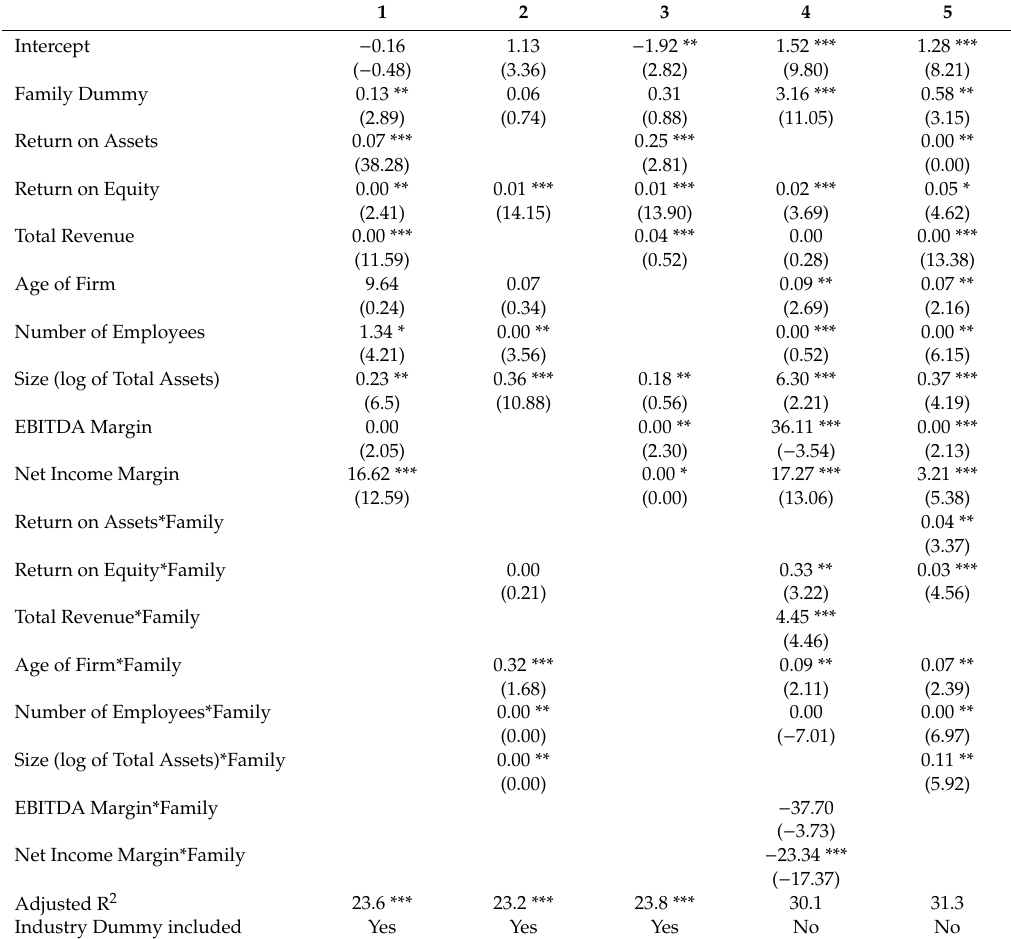
Table 5. Altman Z-Score